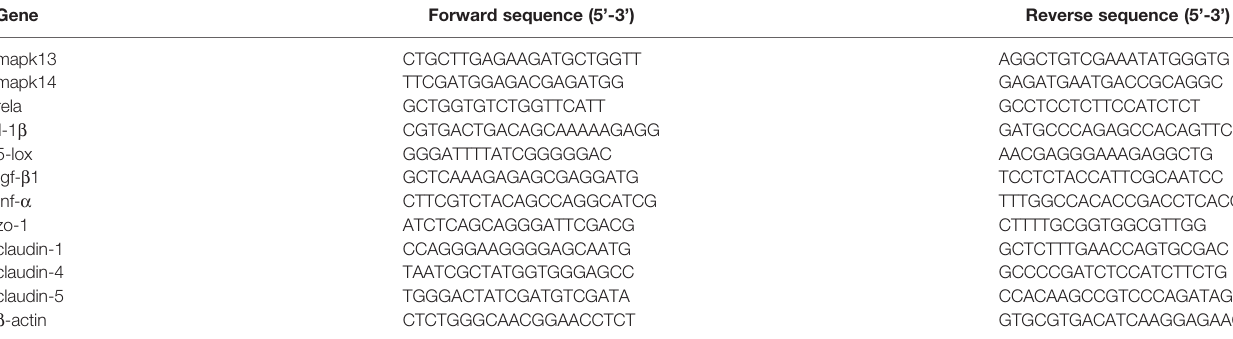
mapk13, mitogen-activated protein kinase 13; mapk14, mitogen-activated protein kinase 14; rela, nuclear factor-kappa B p65; il-1 b , interleukin-1 b ; 5-lox, 5-lipoxygenase; tgf- b 1, transforming growth factor- b 1; tnf- a , tumor necrosis factor- a ; zo-1, zona